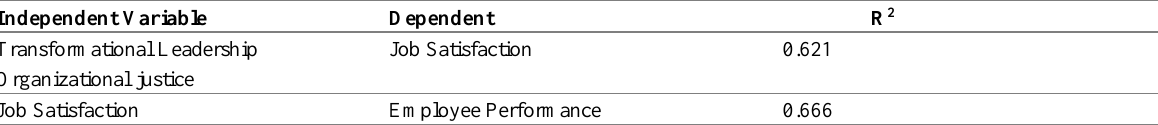
Table 4: R-Squre Test